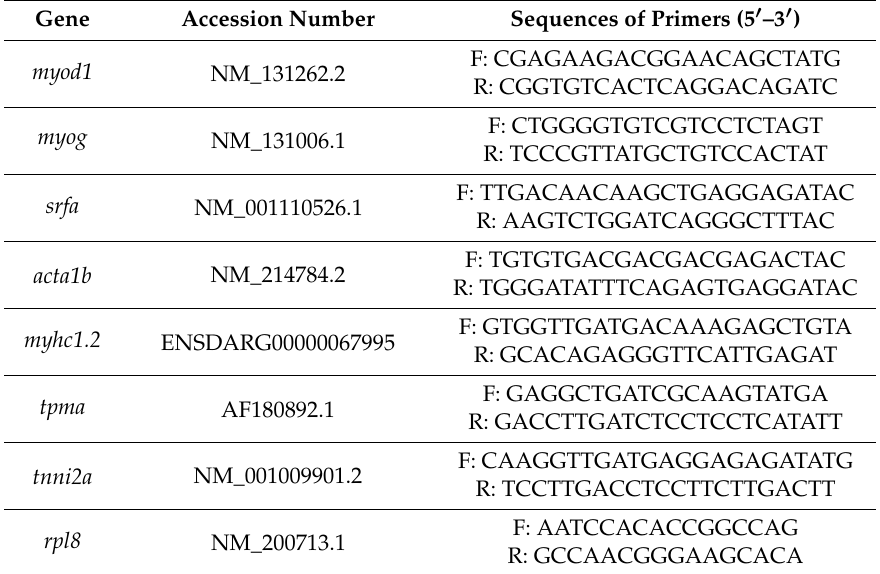
Table 1. Primer pair sequences and accession numbers of the genes of